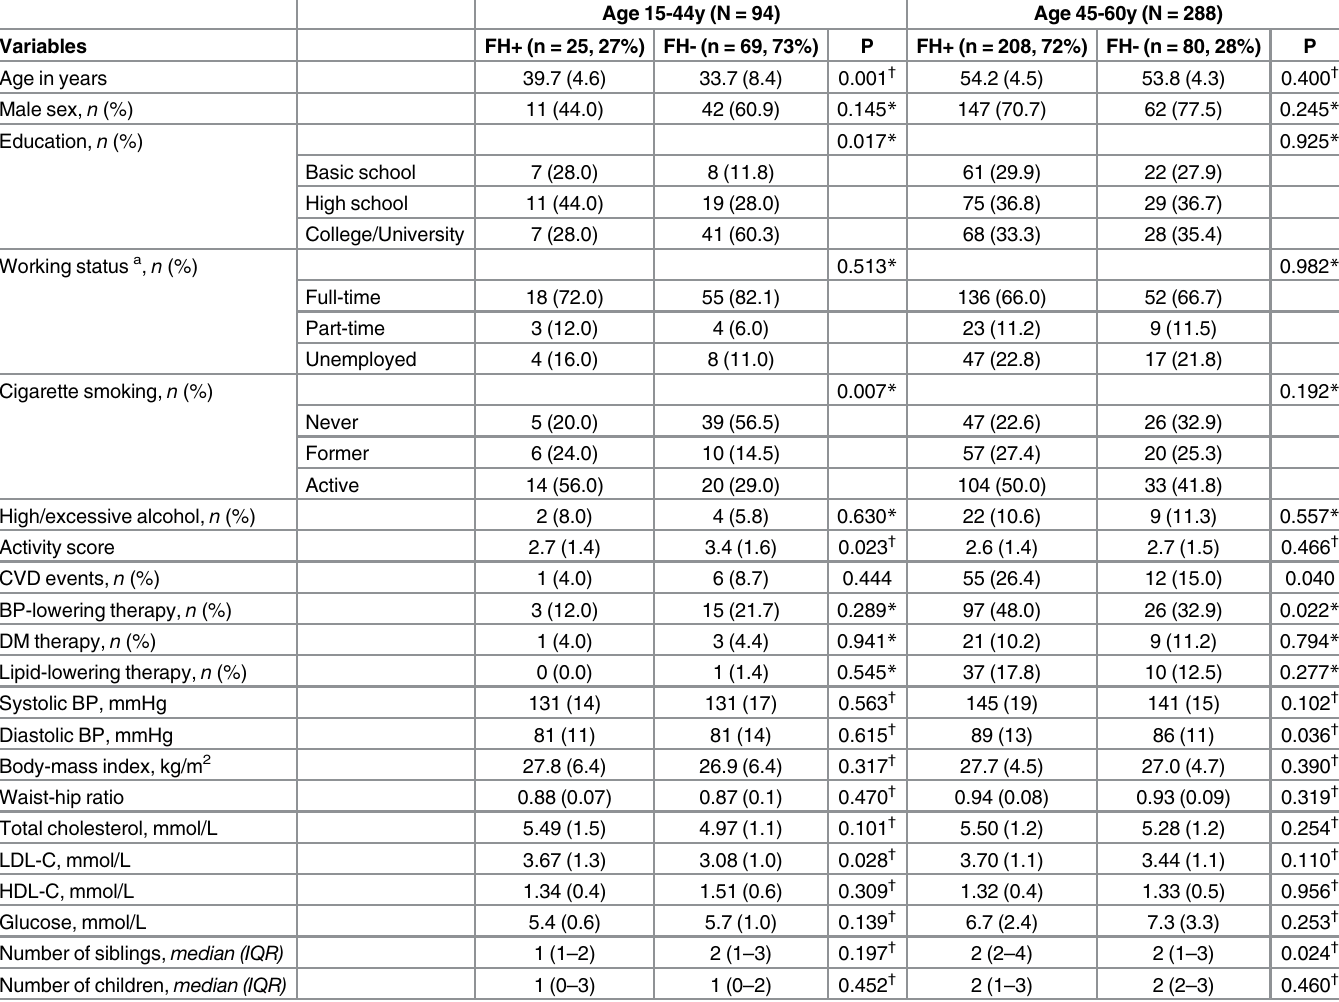
Table 1. Demographic data of 382 young and middle-aged patients included in — the Norwegian Stroke in the Young Study (NOR-SYS) — in Bergen, Norway 2010 –